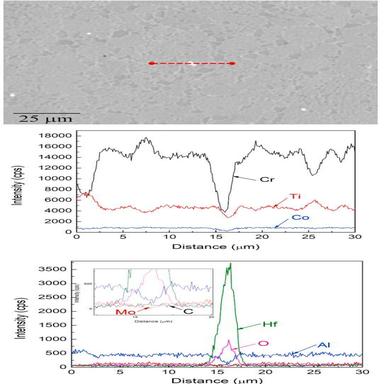
EPMA obtained line scan elemental maps of different alloying elements.